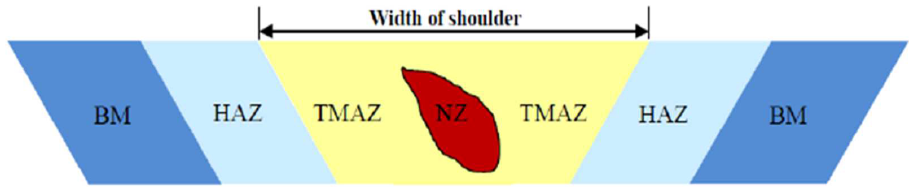
Figure 2. Influence zones of an FSW joint [5].